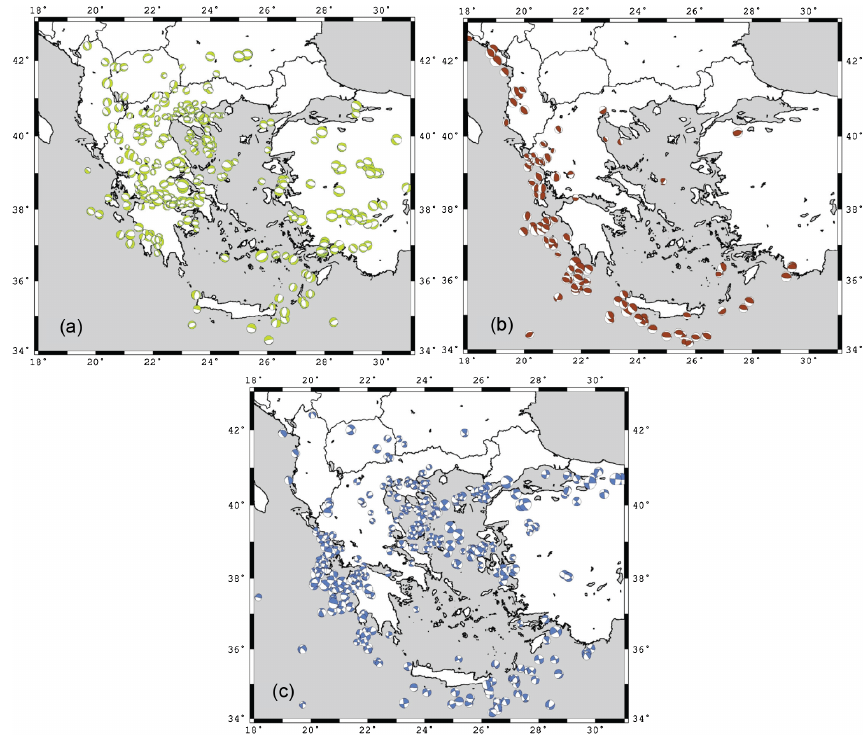
Figure 2. Fault plane solutions for major ( M ≥ 4.0) shallow earthquakes ( a : normal, b : thrust and c : strike-slip) collected and used for the new seismic zonation model